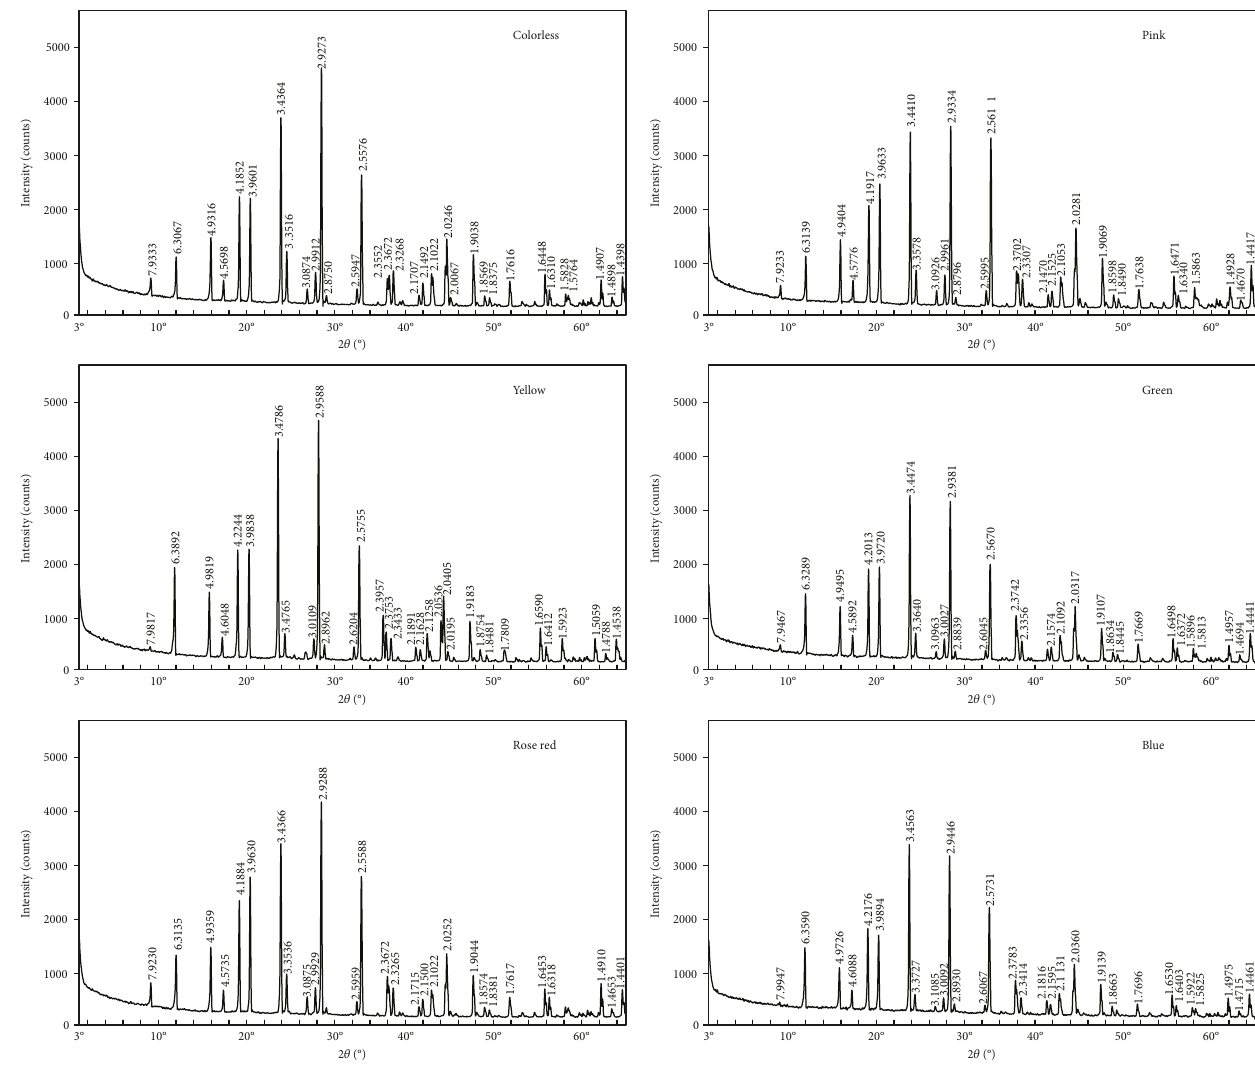
Figure 8: XRD spectra of tourmaline